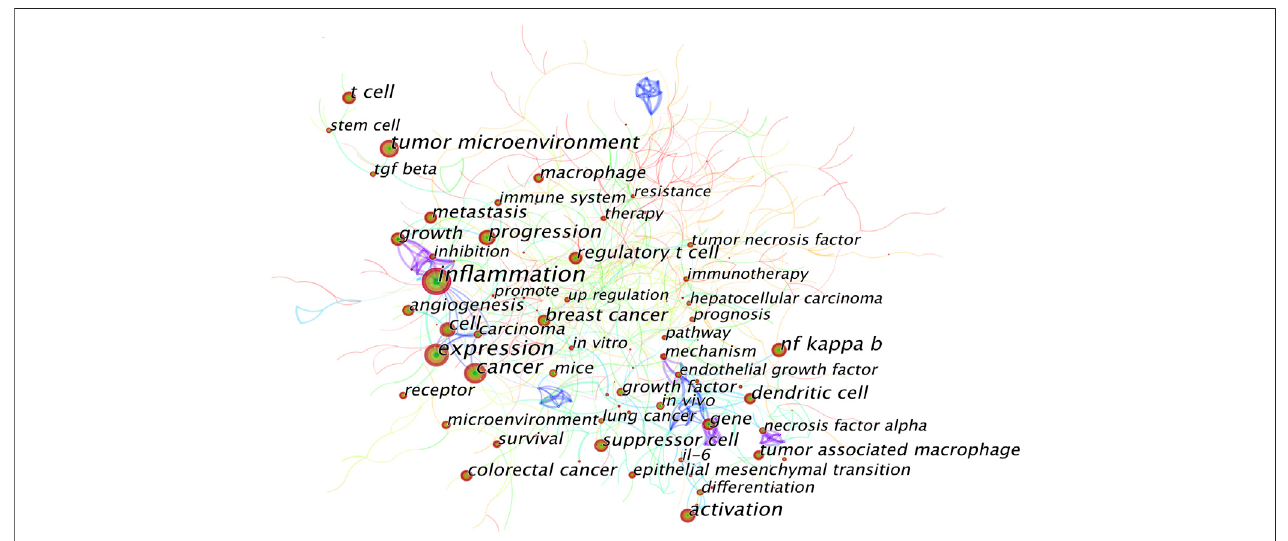
FIGURE 7 | Keyword co-occurrence knowledge map of the in fl ammatory tumor microenvironment.